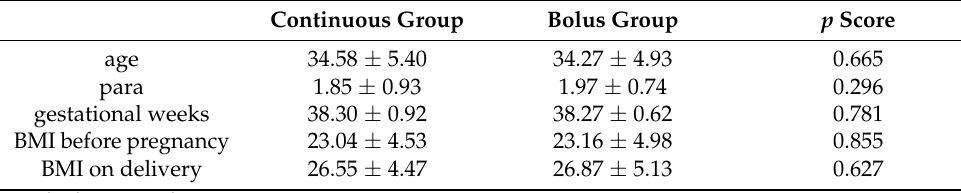
Table 1. Background of the Continuous group and the Bolus group.